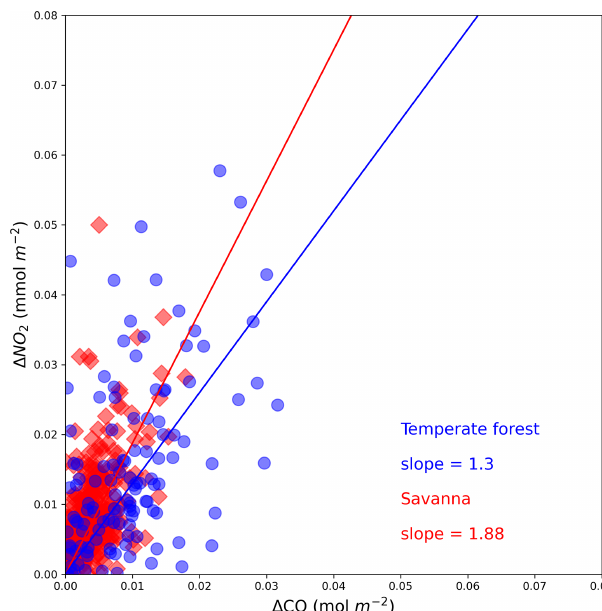
Figure 7. The relationship between daily (cid:49) CO (molm − 2 ) and daily (cid:49) NO 2 (mmolm − 2 ) was derived from TROPOMI for all re- gions. The slope of linear fit with an intercept at zero represents the combustion efficiency of different fire